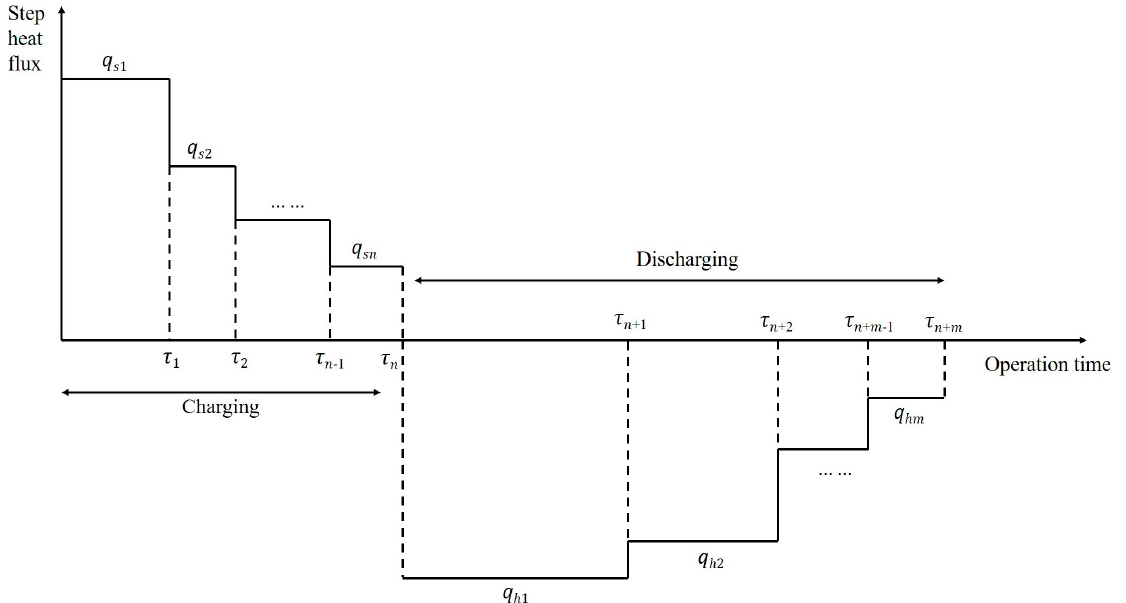
Figure 3. Transient evolution of heat flux during charging and discharging of the deep BTES system.